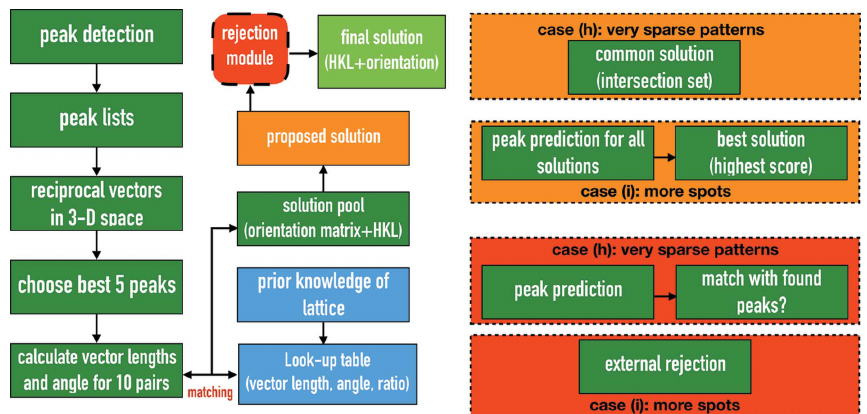
Figure 1 Flowchart of the SPIND indexing algorithm. The five best peaks in each pattern selected based on user-chosen criteria, such as SNR, are used for indexing. The blue boxes refer to prior knowledge and the table is calculated once. The green boxes are steps carried out for each pattern. The (red) rejection module refers to steps ( g ) to ( i